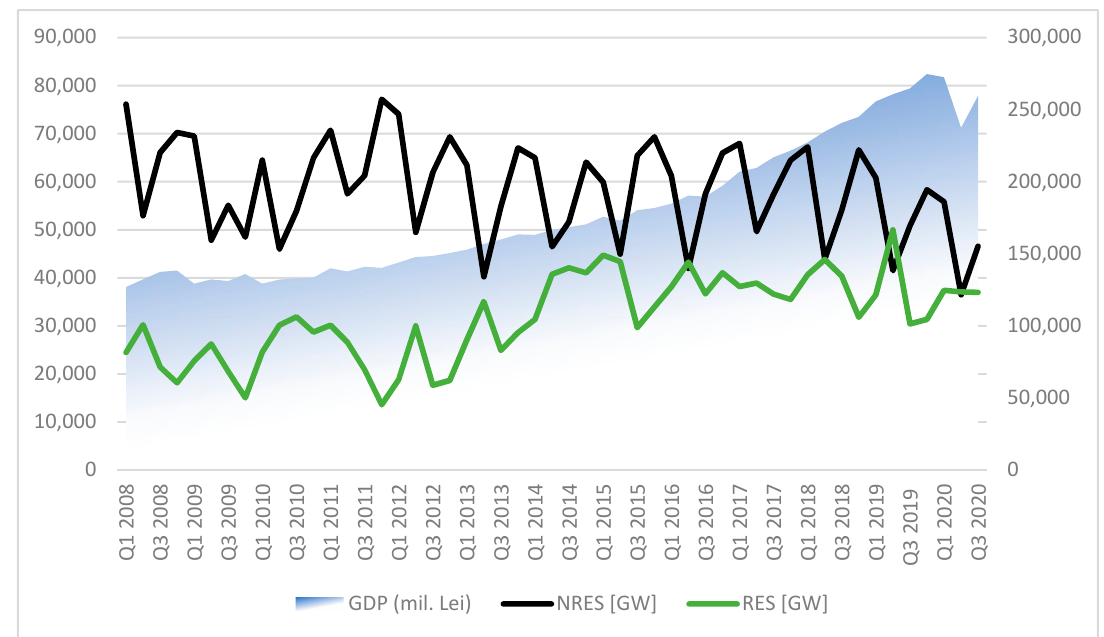
Figure 2. Quarterly GDP and electricity from RESs and NRESs, between Q1 2008 and Q3 2020. Own representation adapted from data [50,53]. Table 3. Pearson correlation for RES and NRES in relation to GDP, between Q1 2008 and Q3 2020.